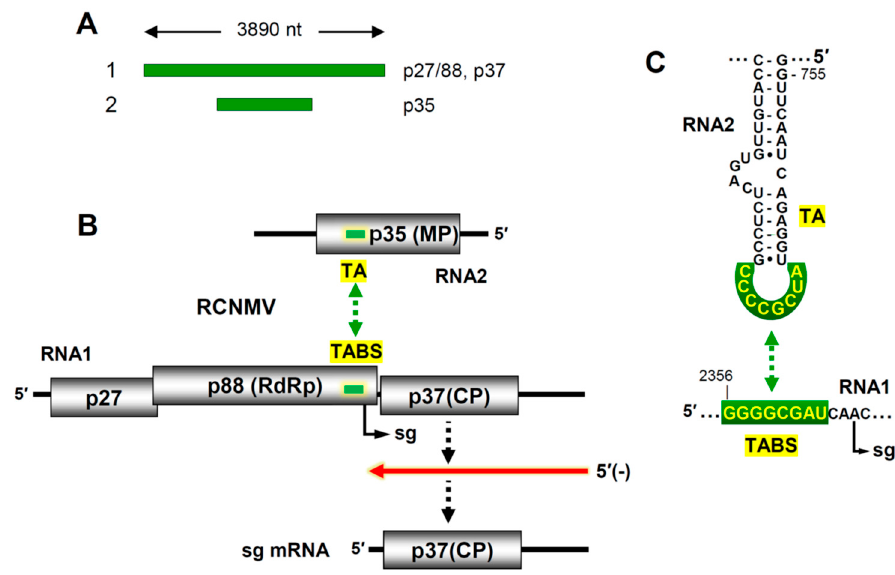
Figure 4. Genome-related structures for Red clover necrotic mosaic virus. ( A ) Linear representation of the RCNMV genome segments, labeled 1 and 2 (left), along with corresponding proteins encoded by each (right). ( B ) Schematic representation of RCNMV RNA1 and RNA2 and their encoded proteins (boxes). The relative location of the TA and TABS in each genome segment is indicated by a dark green bar. Sg mRNA transcription occurs via production of a sg mRNA-sized ( − )RNA intermediate (red), that is then used as a template to transcribe the sg mRNA. ( C ) Depiction of the sequences (highlighted in green) that are involved in the TA–TABS tRRI between RCNMV RNA1 and RNA2 that activates sg mRNA transcription [47].